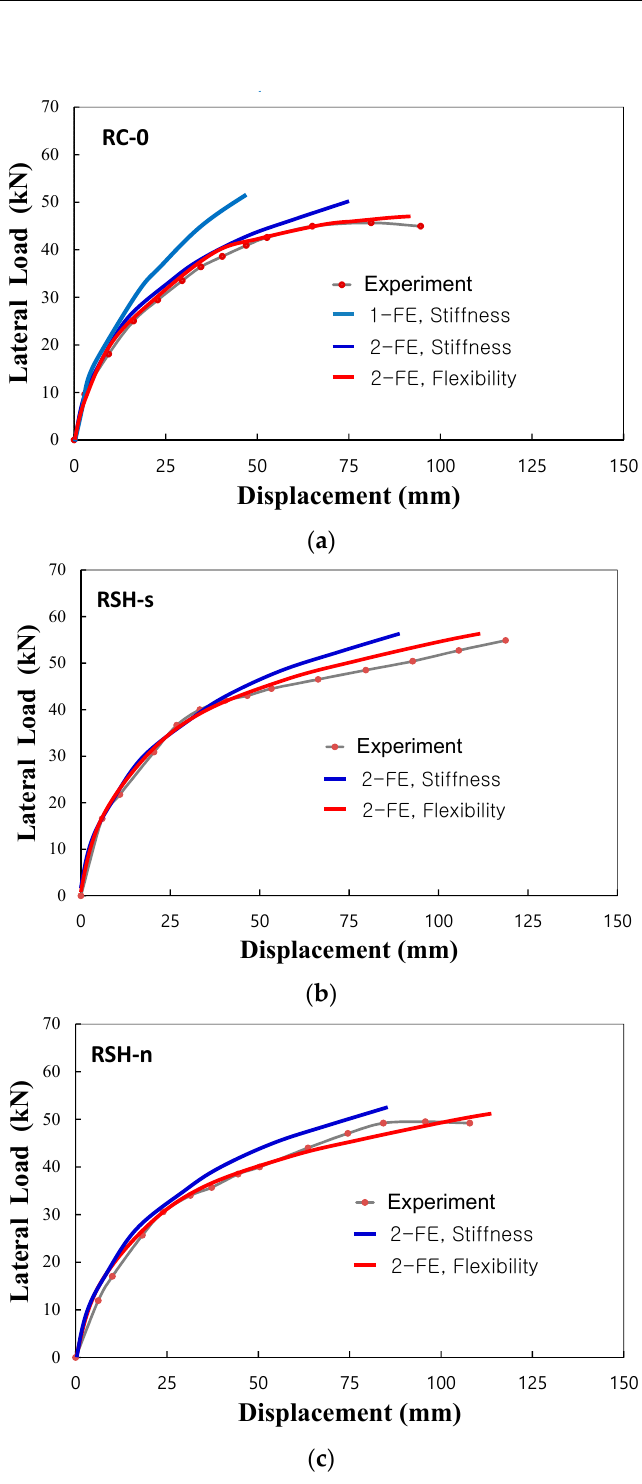
Figure 9. Experiments and predictions of lateral load–displacement responses, ( a ) RC-0, ( b ) RSH-s, ( c ) RSH-n.